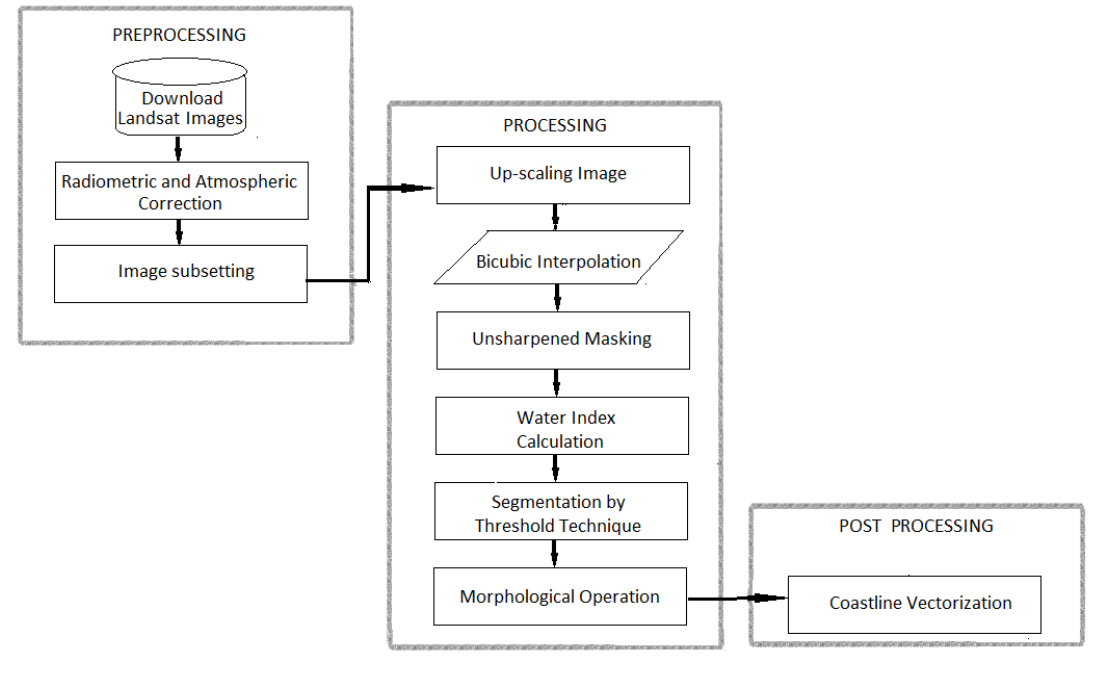
Figure 2. Study workflow for the methodology used in coastline